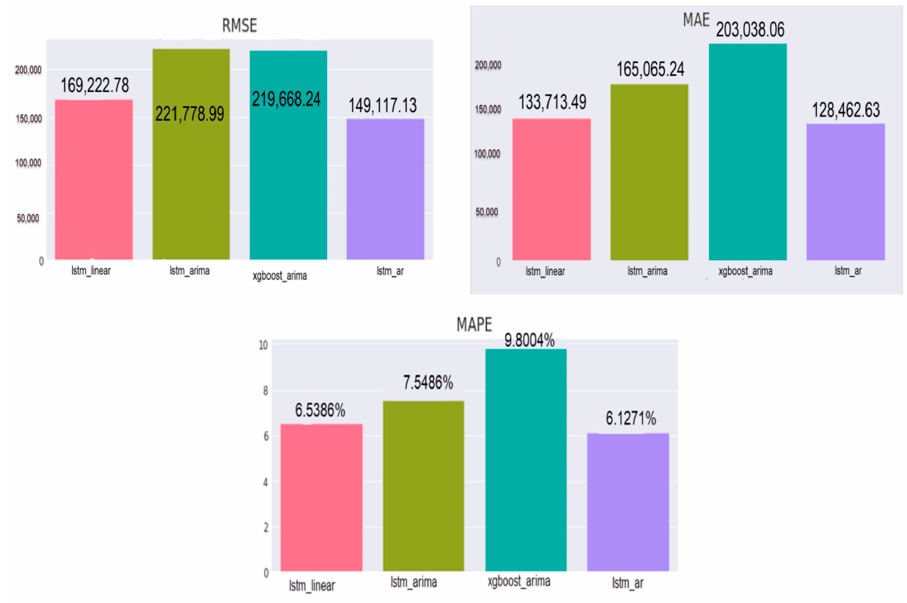
Figure 5. The ranked accuracy metrics of all hybrid models.